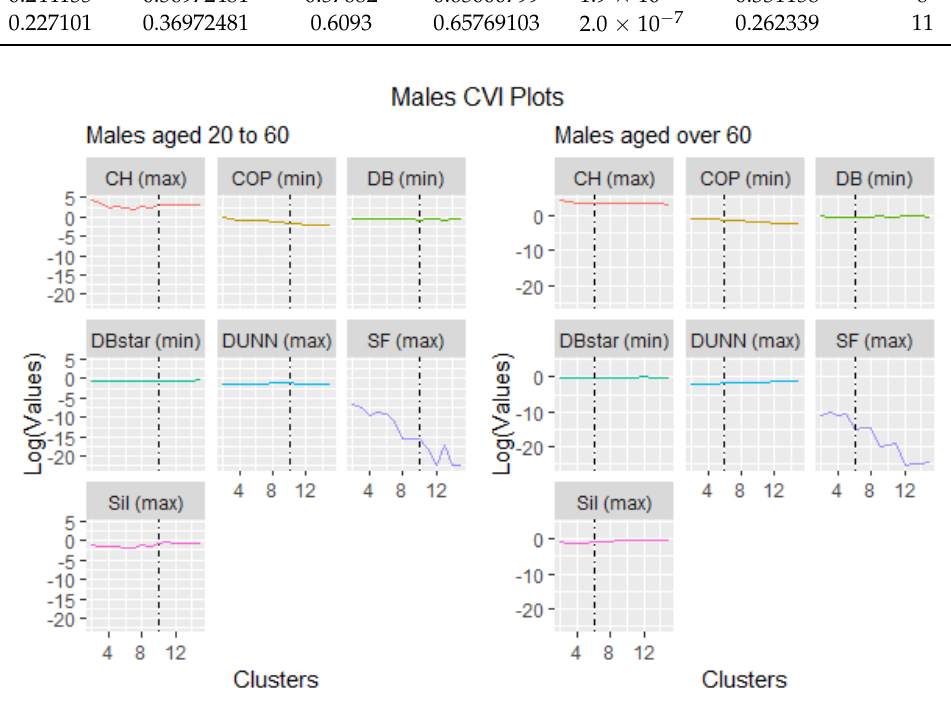
Figure 1. Male CVI plots.